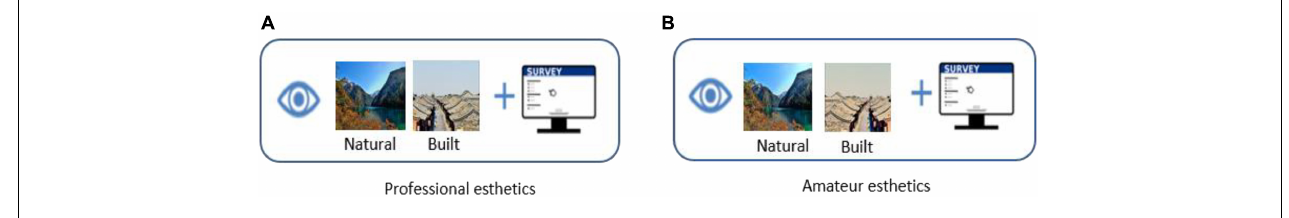
FIGURE 2 | Procedure for eye-tracking